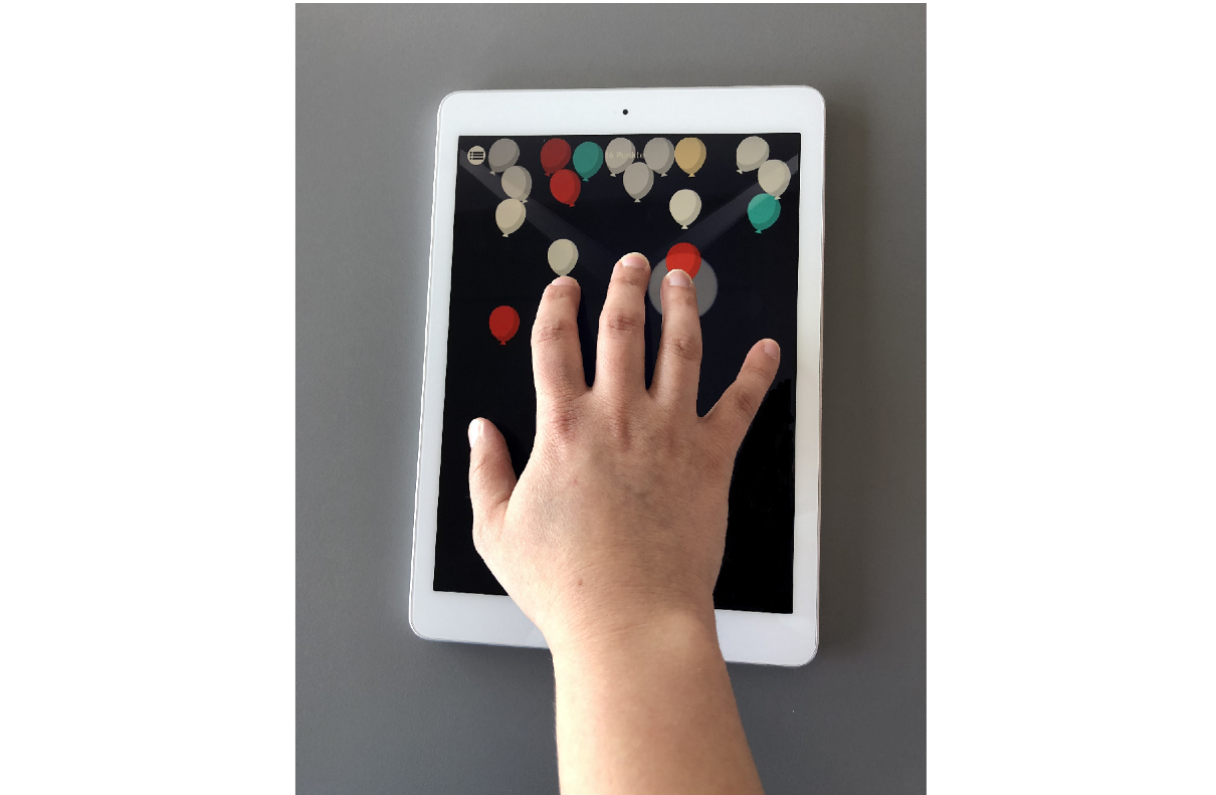
Figure 1. The TAD-MS app contains six dexterity exercises, including selective finger tapping (balloons), which is shown here. Other exercises are acrobat seesaw (pinch grip), the wheel (rotation and flexion/extension in various joints in fingers), and elevator I (selective finger rotation). TAD-MS: tablet app–based dexterity home-based intervention in multiple